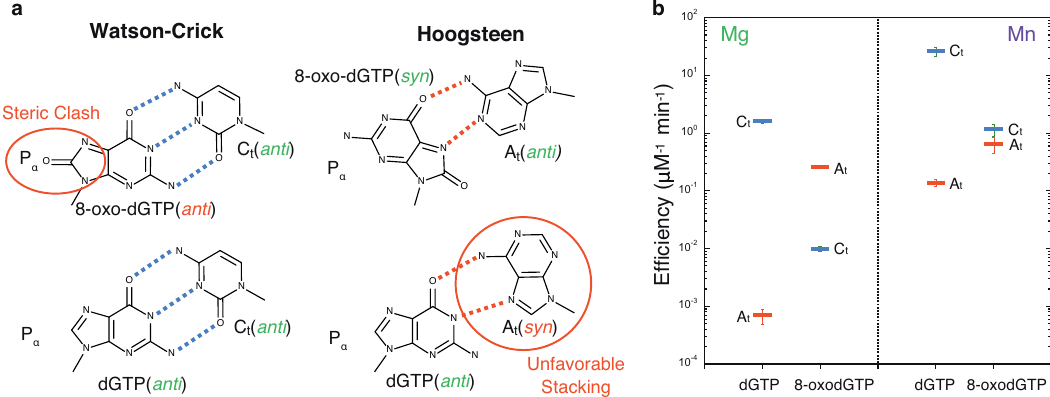
Fig. 1 Base-pairing and speci fi city of 8-oxodGTP insertion. a Base-pairing of dGTP and 8-oxodGTP in the pol μ active site. The anti -conformations of undamaged dGTP and template cytosine (C t ) enable Watson – Crick base-pairing (bottom left). The steric and electrostatic clash (red circle) between O8 and P α of 8-oxodGTP( anti ) opposite C t ( anti ) discourages adoption of the anti -conformation (top left). Adoption of the syn -conformation enables favorable 8-oxodGTP Hoogsteen base-pairing with template adenine (A t ) in anti -conformation (top right). Incorporation of dGTP( anti ) opposite A t ( syn ) creates unfavorable (red circle) interactions in the template strand (bottom right). Watson – Crick hydrogen bonding is shown with blue dashed lines, while Hoogsteen interactions are shown as red dashed lines. The conformation of each base is indicated in parentheses. b Catalytic ef fi ciencies of dGTP and 8- oxodGTP insertion opposite templates C (C t ) or A (A t ) in the presence of Mg 2 + (left panel) or Mn 2 + (right panel) (see Supplementary Table 1). Catalytic ef fi ciency ( k cat /K M , in μ M − 1 min − 1 ) is indicated as a blue line for insertion opposite C t and as a red line for insertion opposite A t . Error bars shown represent standard errors (S.E.) derived from triplicate